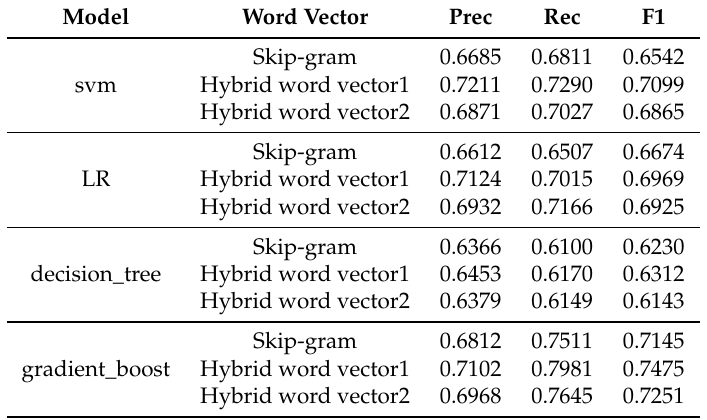
Table 5. Accuracy comparison of emotion classification experiments based on various text representations.